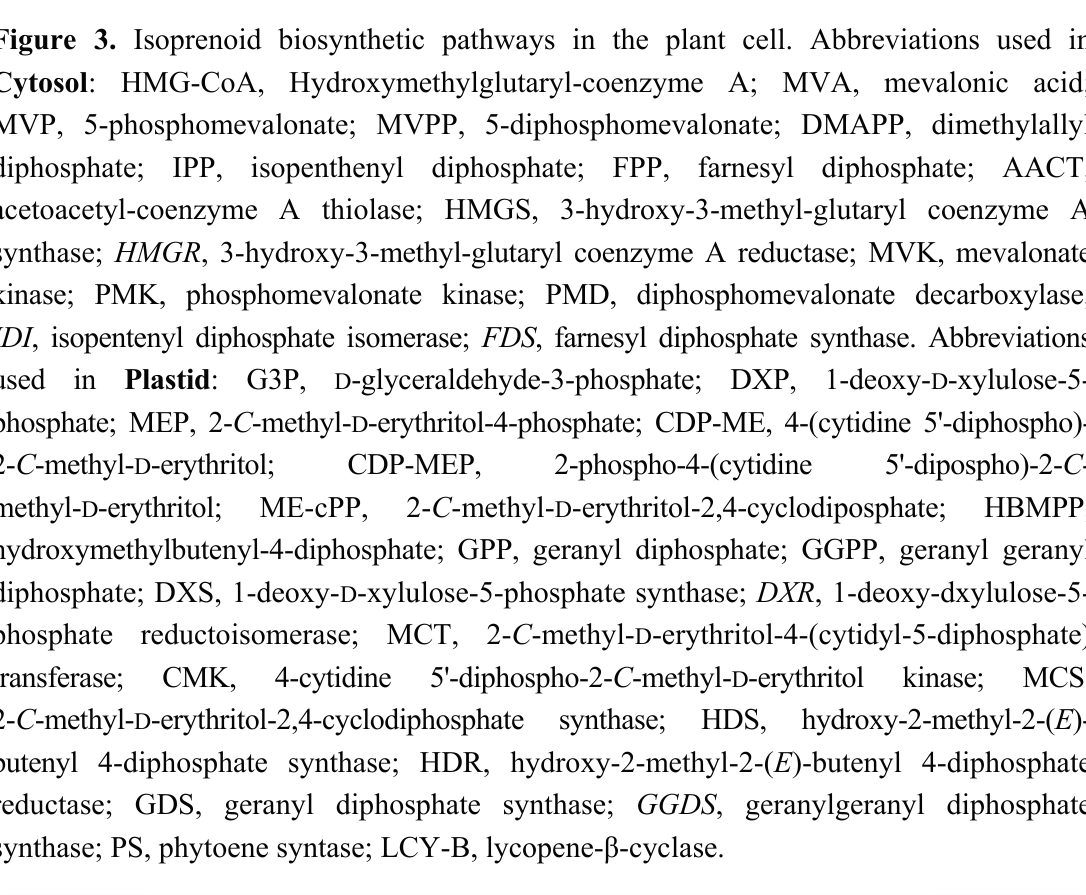
Figure 3. Isoprenoid biosynthetic pathways in the plant cell. Abbreviations used in Cytosol : HMG-CoA, Hydroxymethylglutaryl-coenzyme A; MVA, mevalonic acid; MVP, 5-phosphomevalonate; MVPP, 5-diphosphomevalonate; DMAPP,